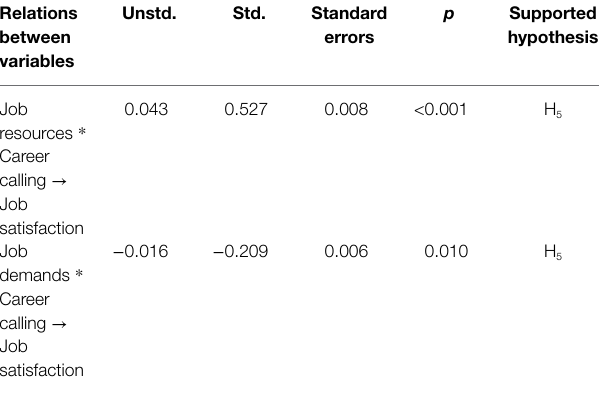
TABLE 9 | Examining moderating effect.